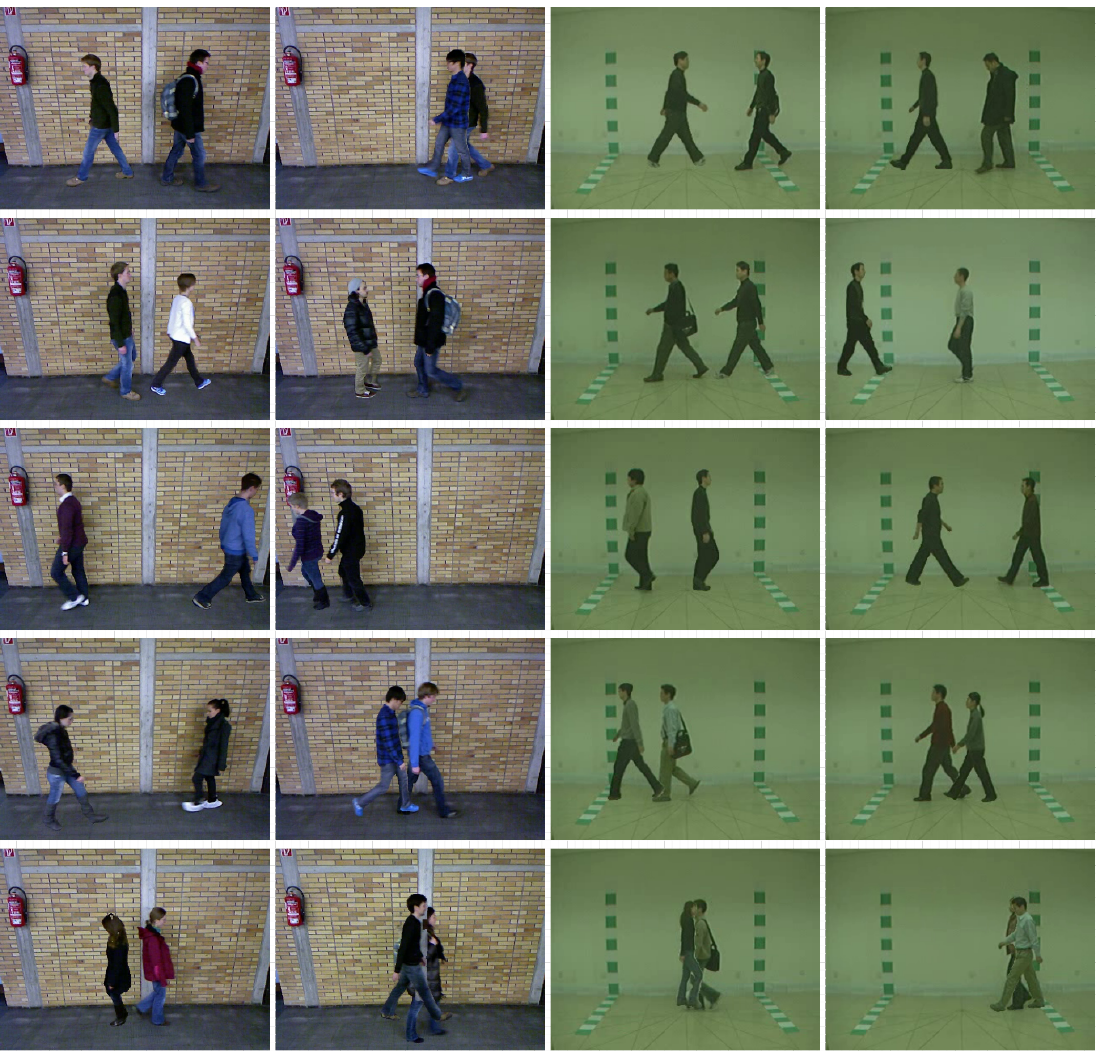
Figure 4. MultiTUM-GAID and MultiCASIA-B datasets. Different situations produced by our framework. Top four rows show frames generated with different subjects and different walking paths, exhibiting the quality of the output data. Bottom row shows some segmentation errors that produce lower quality outputs. The two leftmost columns show samples generated from TUM-GAID. The two rightmost columns are generated from